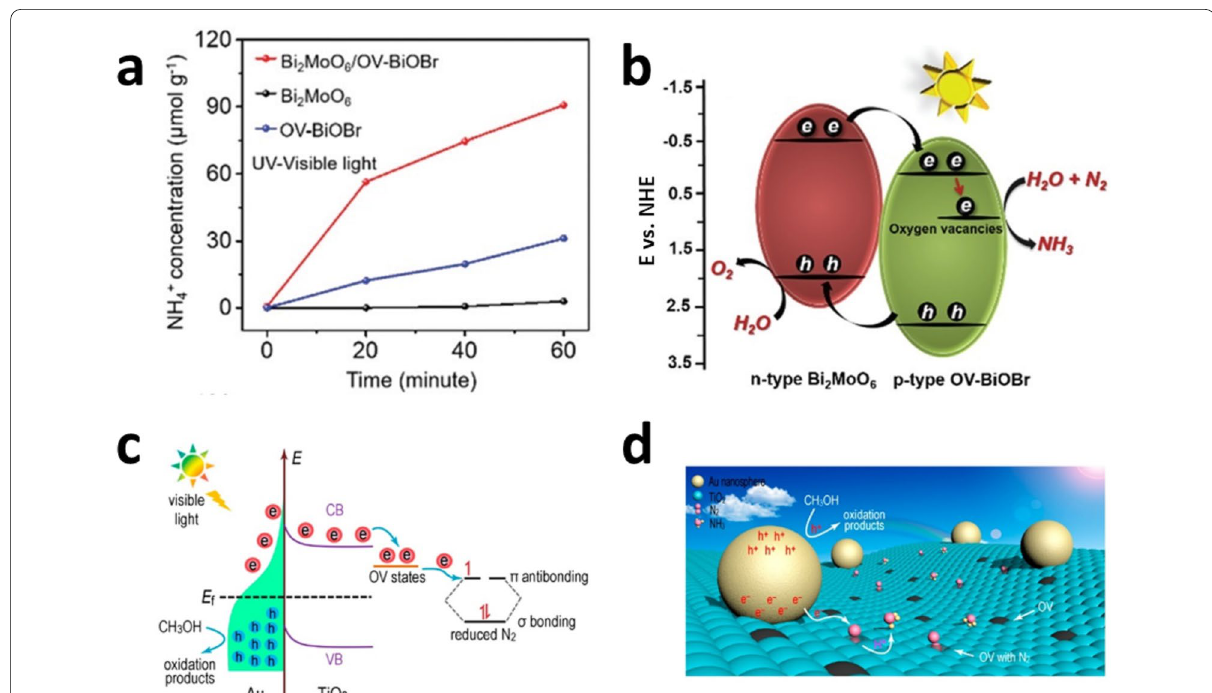
Fig. 5 a NH 4 + concentrations of Bi 2 MoO 6 /Ov-BiOBr heterojunctions, Bi 2 MoO 6 and BiOBr alone, respectively. b The scheme of proposed Bi 2 MoO 6 / BiOBr heterojunctions. Reproduced with permission [51]. Copyright 2019, The Royal Society of Chemistry. c The schematic reaction mechanism and d the artistic illustration of Au/TiO 2 -Ov photocatalyst. Reproduced with permission [52]. Copyright 2018, American Chemical